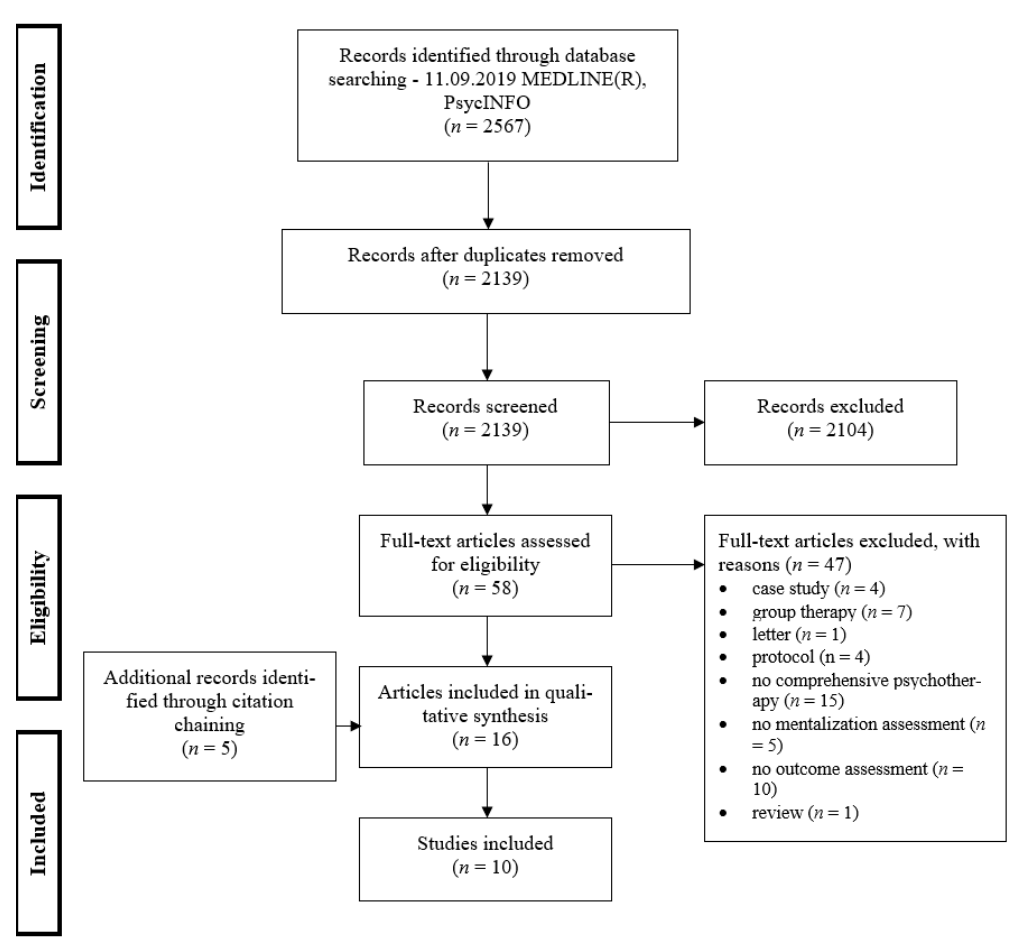
Figure 1. PRISMA flow diagram (Moher et al. [38]).